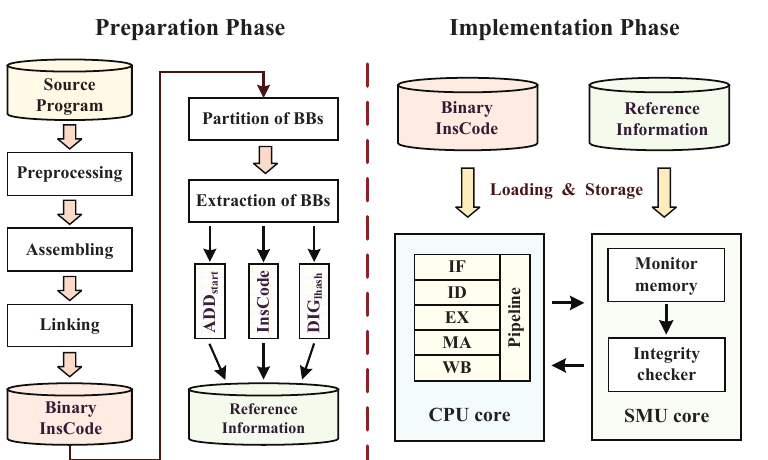
Figure 4. The static extraction preparation phase of reference information and the implementation phase for real-time